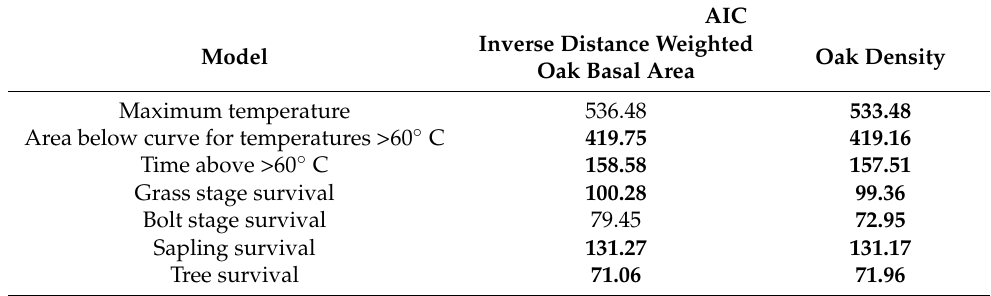
Figure A2. Longleaf pine survival probability as a function of oak (i.e., heterospecific) density with values partitioned by life stage. Results shown from full GLMM containing interactions between life stage and neighborhood metrics as well covariates for gap fraction, slope, understory density, and ground vegetation density. Shaded ribbons indicate 95% confidence intervals of parameter estimates by life stage. Table A1. Comparison of AIC values for candidate LMs and GLMMs used to assess the response of fire temperature and longleaf pine survival probabilities to biotic neighborhoods and abiotic conditions that included different oak neighborhood metrics. Best fit models are shown in bold. Oak density provided equal (AIC values within 2.0) or better fits in all modeling